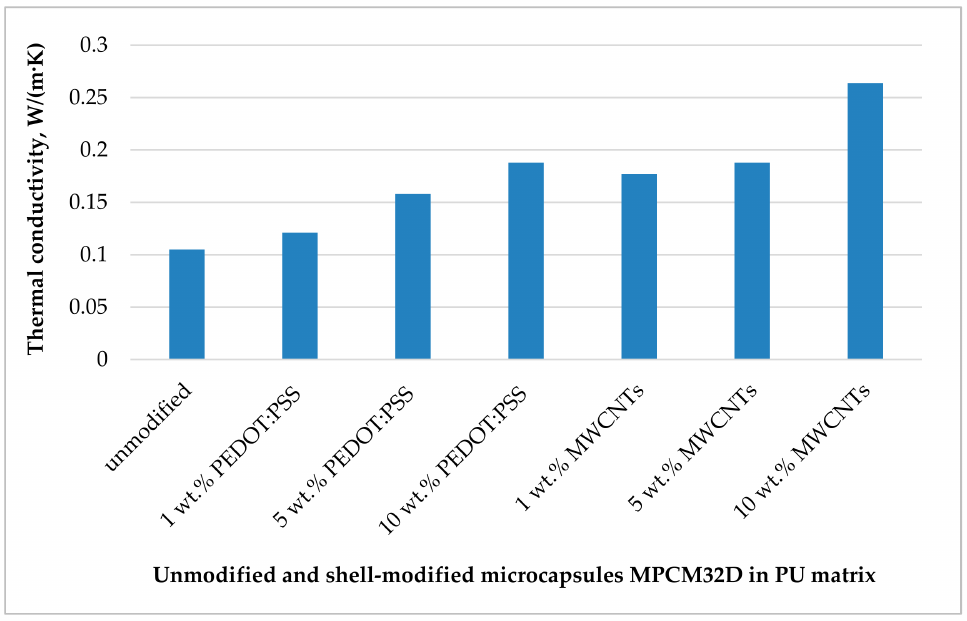
Figure 7. Thermal conductivity of unmodified and shell-modified PCM microcapsules MPCM32D in a polyurethane